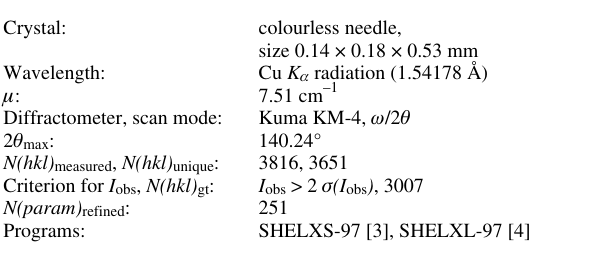
Table 1. Data collection and